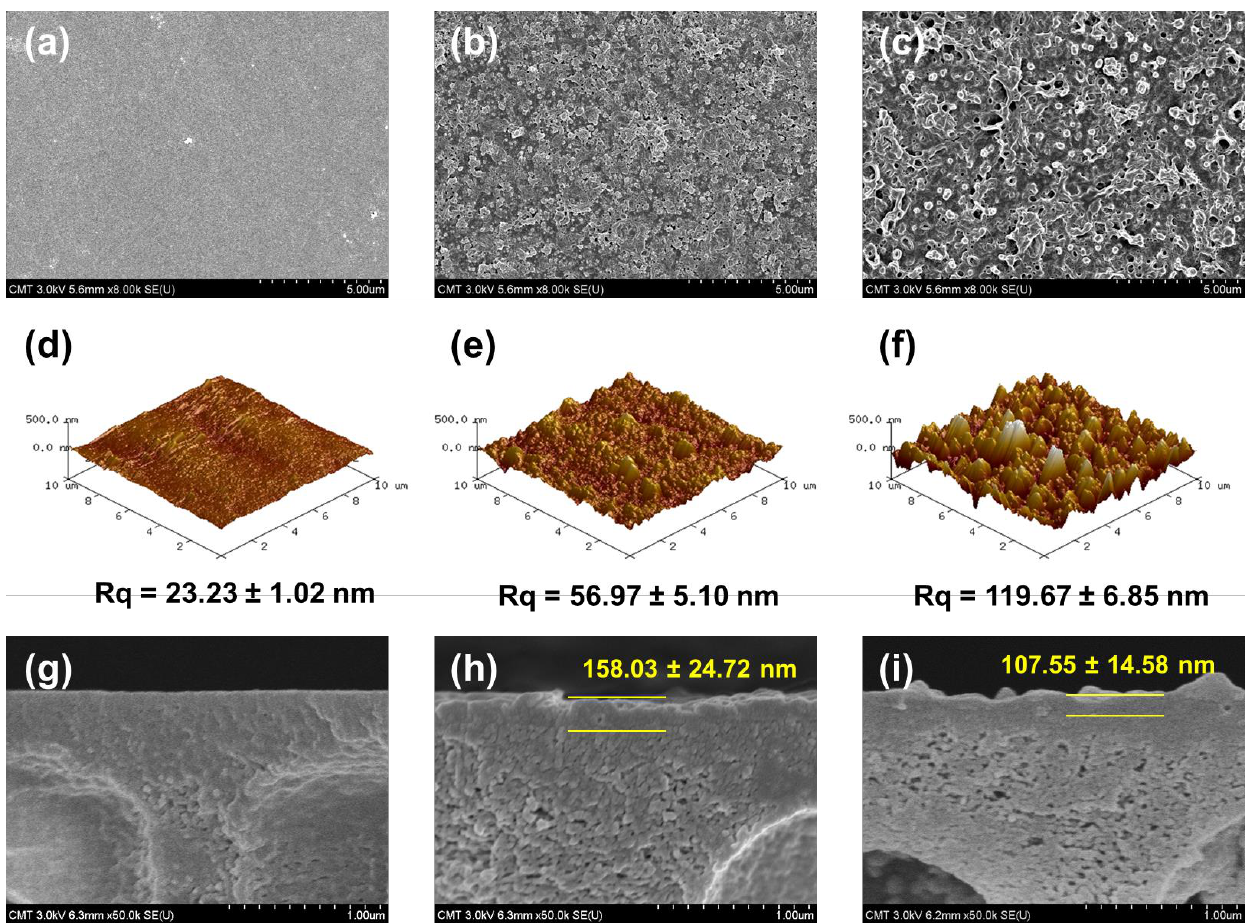
Figure 3. FESEM and AFM morphology: ( a , d , g ) hPAN; ( b , e , h ) TFC; and ( c , f , i ) TFN membranes.